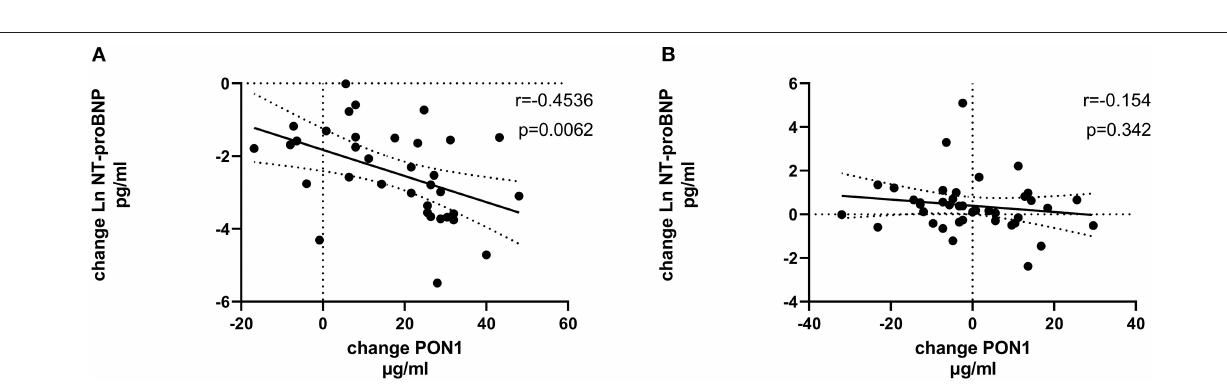
FIGURE 6 | Change in LV diastolic volume vs. change in PON1 mass. (A) Transplant group. (B) Dialysis group.